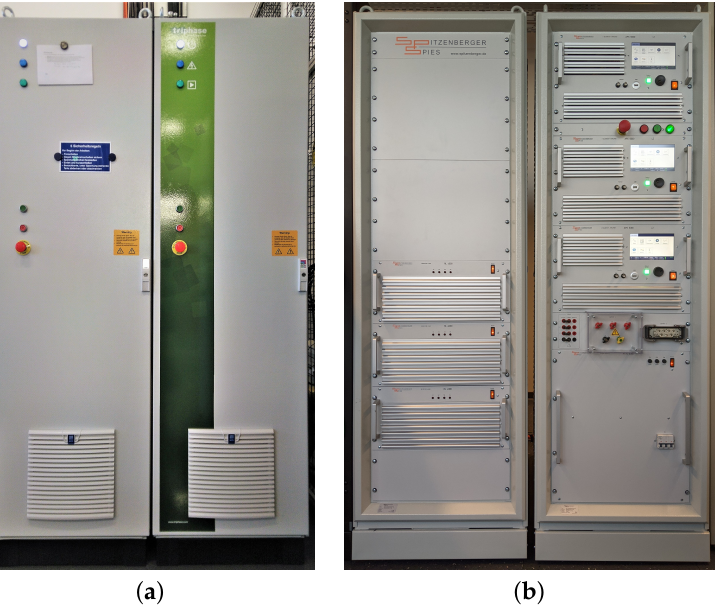
Figure 16. Four quadrant amplifiers applied in the experimental PHiL setup. ( a ) Switching amplifier; ( b ) Linear